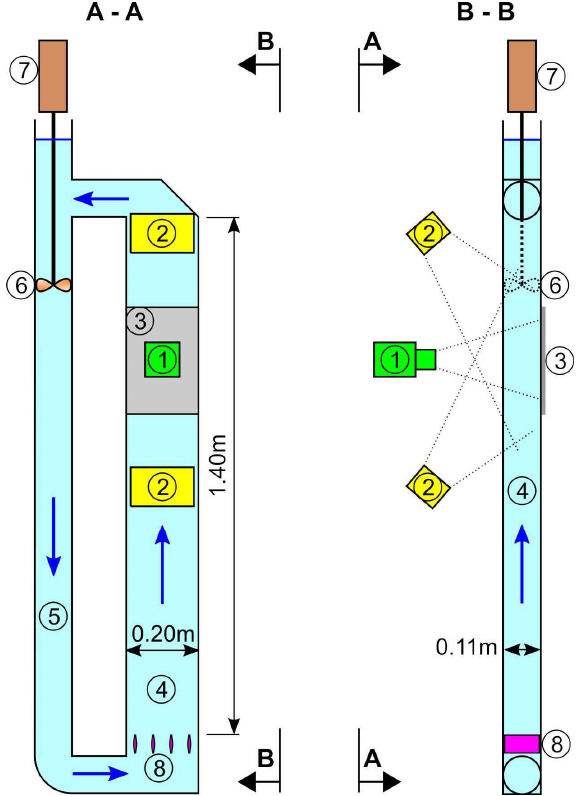
Fig. 1. Schematic sketch of fluidization cell; 1) camera, 2) light, 3) background 4) transparent part of fluidization, 5) pipe part, 6) propeller, 7) electric drilling machine, 8) shutter